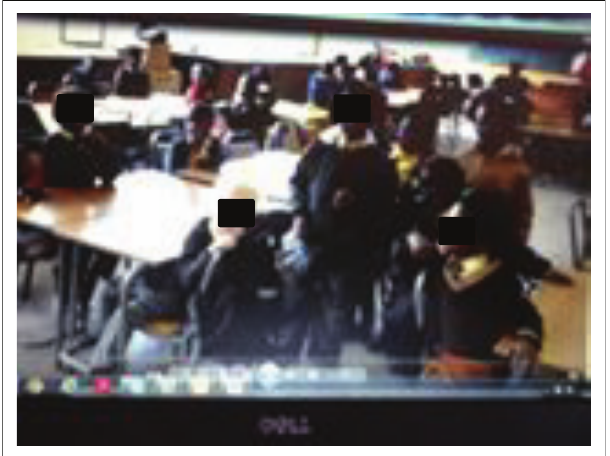
FIGURE 5: Inattentive